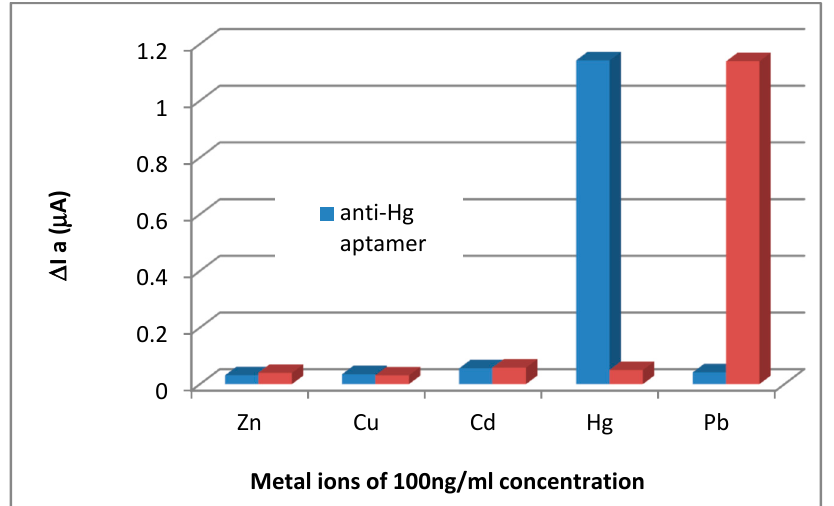
Figure 5. The cross-sensitivity tests: responses of anti-Hg 2 + aptamer (blue) and anti-Pb 2 + aptamer (red) to Zn 2 + , Cu 2 + , Cd 2 + , Hg 2 + , and Pb 2 + ions in 100 ng / mL concentrations. Table 1. ICP-MS testing results of real samples.